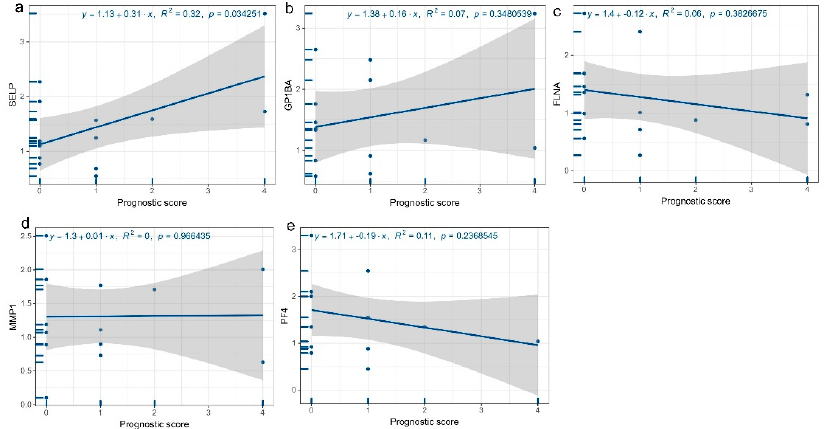
Figure 4. Regression plots of platelet activation-related proteins and prognostic scores. ( a ) SELP prognostic score regression, ( b ) GPIb α vs. regression of the prognostic score, ( c ) FLNA vs. prognostic score regression, ( d ) MMP1 vs. prognostic score regression, ( e ) PF4 vs. prognostic score regression.